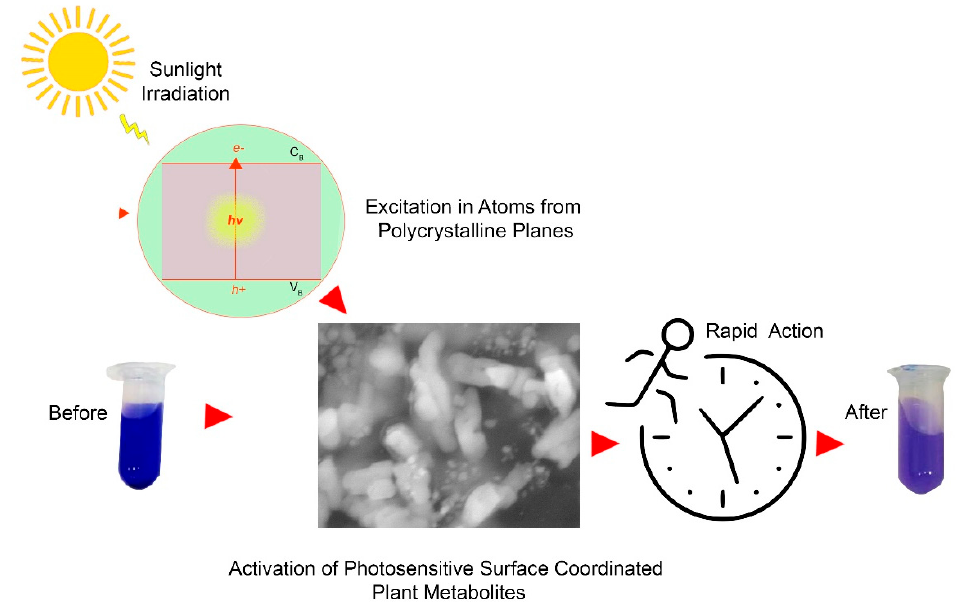
Figure 8. Hypothetical explanation of the photocatalytic experiment.